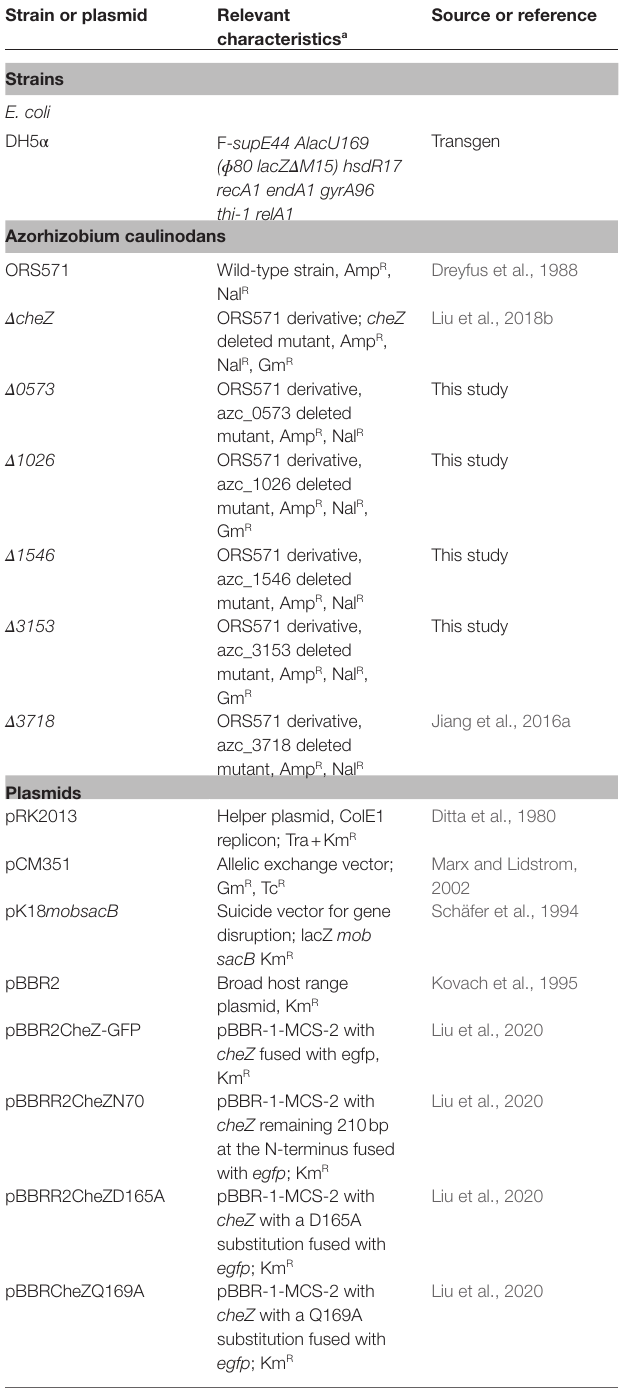
TABLE 1 | Bacterial strains and plasmids used in this